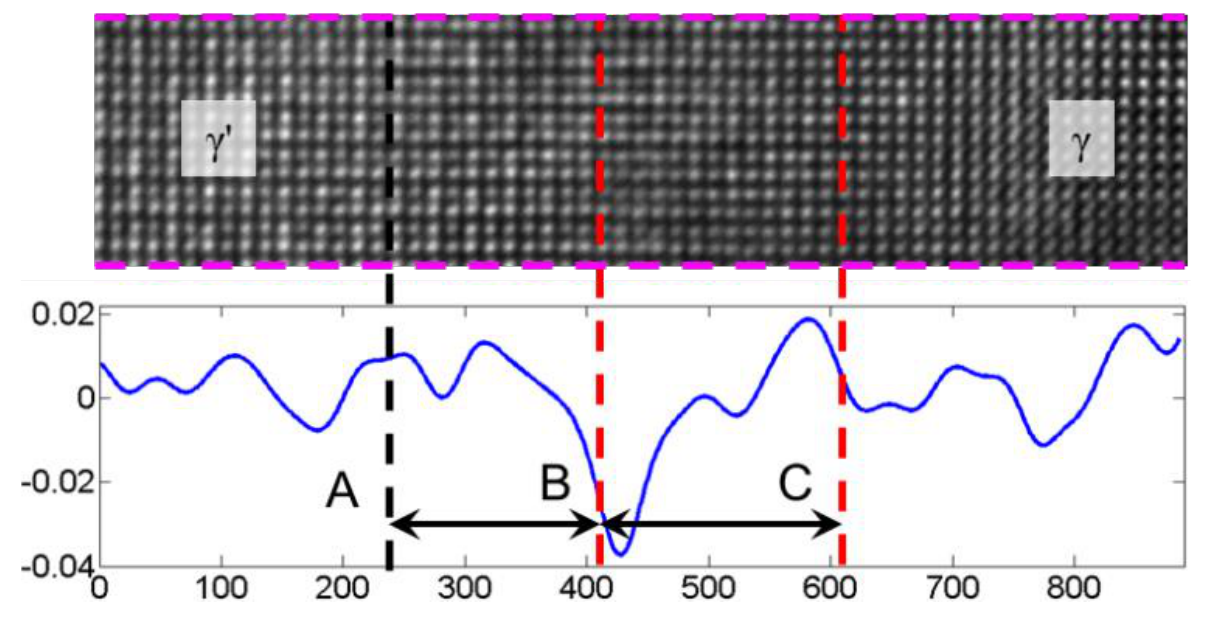
Figure 7. Average strain distribution profile along the [020] direction near the two − phase interface.